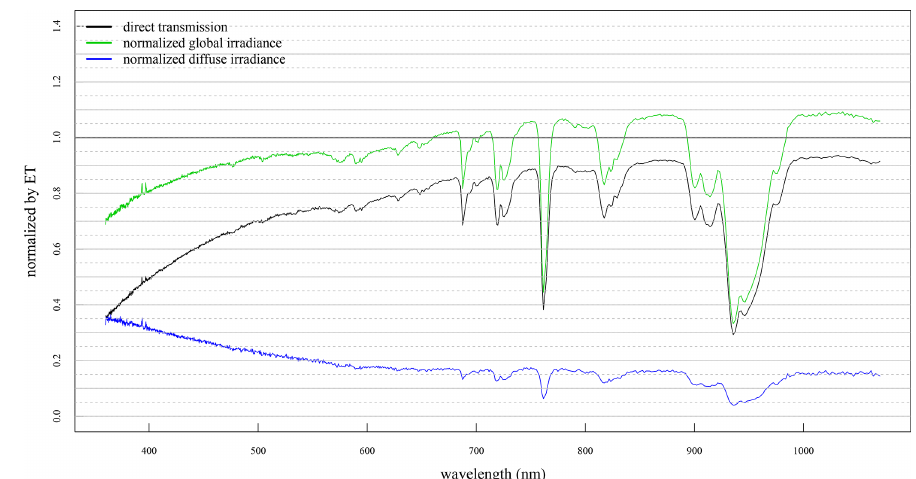
Figure 7. RSS spectra for an instance where there is a clear path to the Sun on a partly cloudy day. Note that normalized global irradiance exceeds 100% at many of the longer wavelengths.